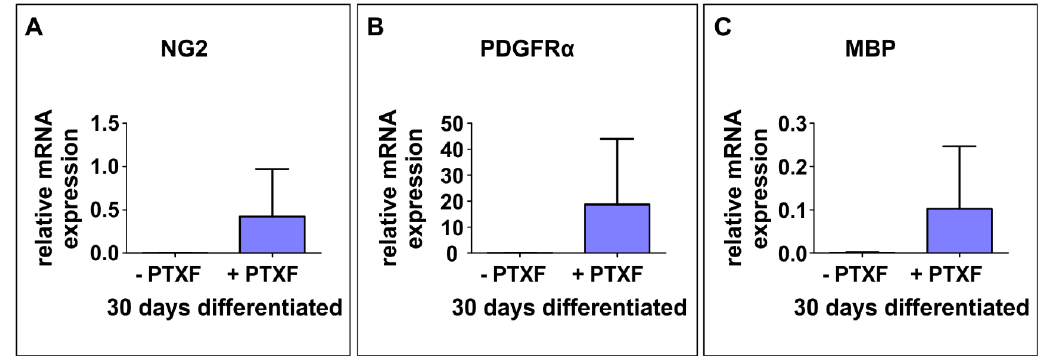
Figure 5. Early c-REL inhibition leads to a cell fate shift into the oligodendrocyte fate. ( A – C ) Real time